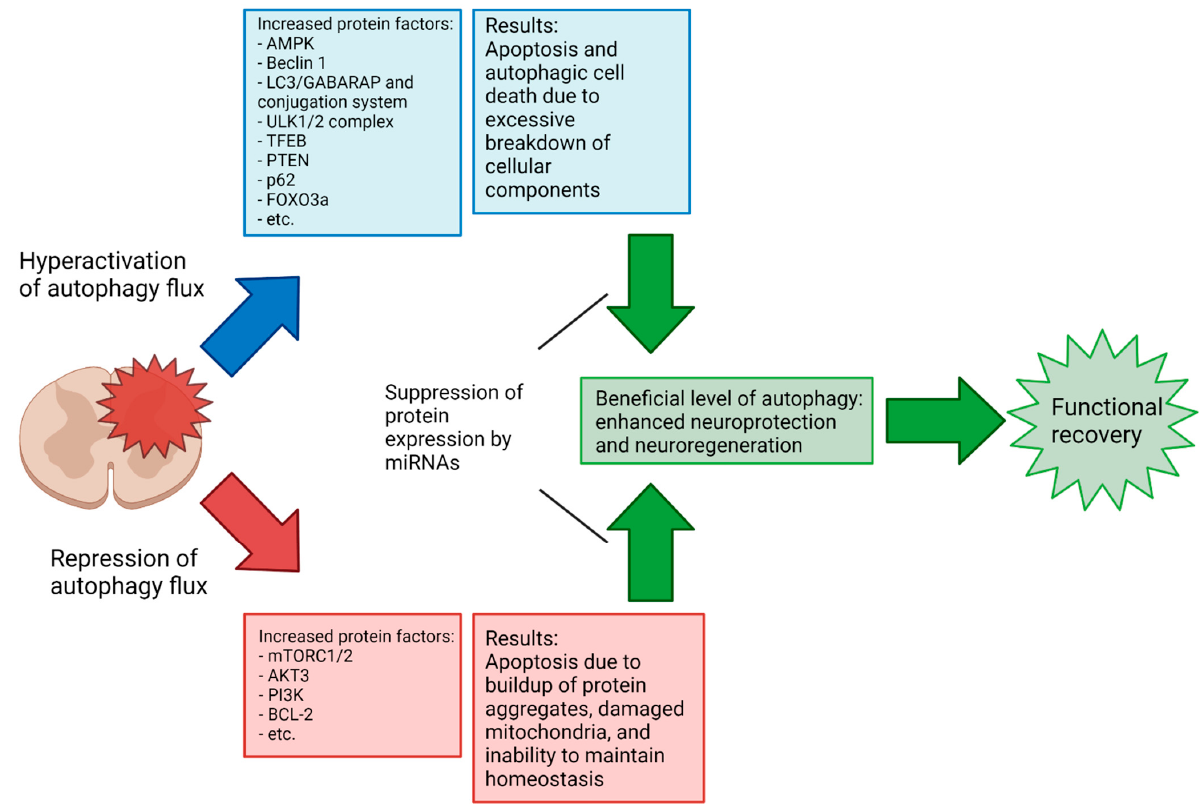
Figure 6. Potential role of miRNAs in promoting functional recovery in SCI. Autophagy may